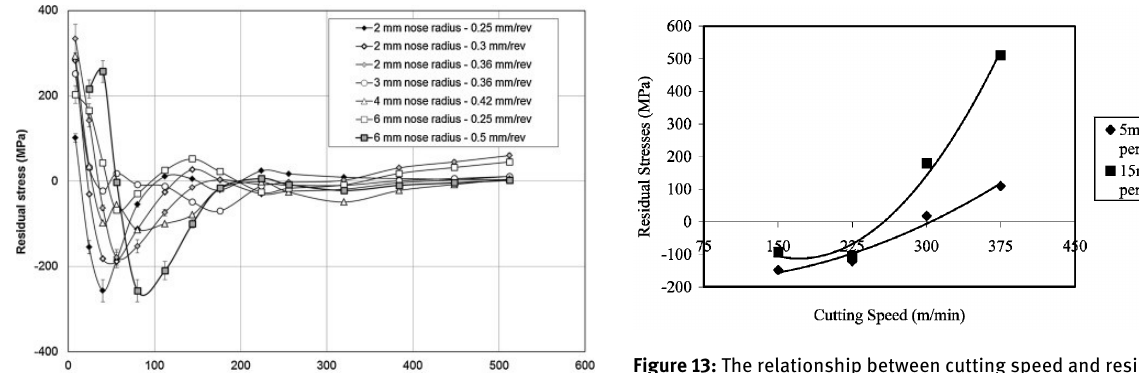
3 mm, 4 mm and 6 mm. It was reported that larger sur- face tensile stress levels (up to 1550 MPa) and depths (up to 100 µm) were seen with increased tool nose radius. This was attributed to decreased chip thickness at trailing edge,